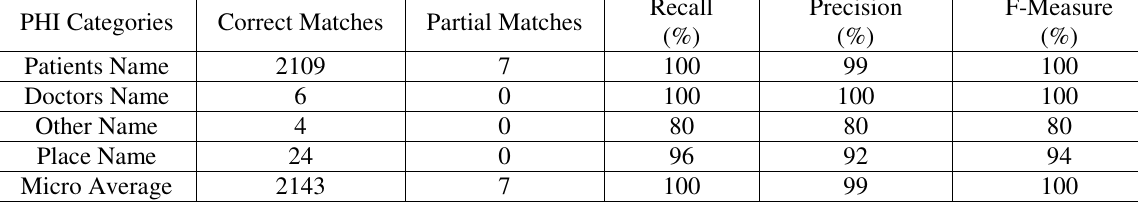
TABLE 8: IDENTIFICATION OF PHI CATEGORIES ON EVALUATION